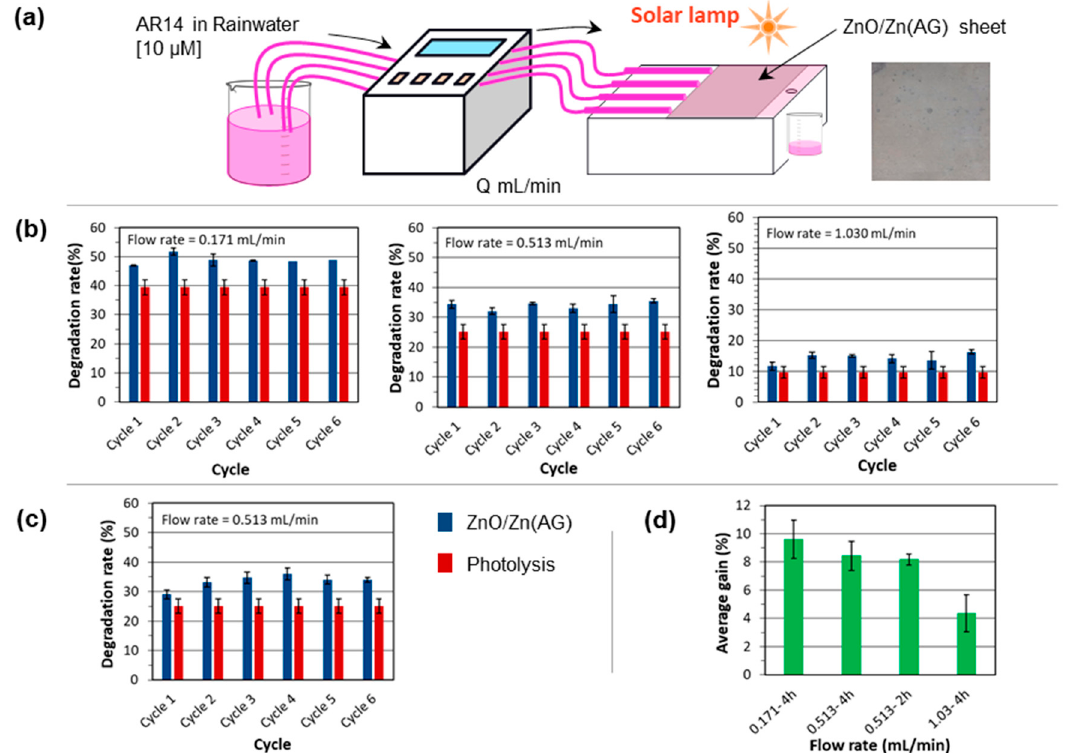
Figure 4. ( a ) Schematic of the experimental set-up of runoff water photodegradation with ZnO NSs on Zn roof sheets. Photodegradation rate of AR14 under artificial solar light with or without the presence of ZnO NSs: ( b ) at different flow rate: 0.171, 0.513, and 1.03 mL/min for 4 h-sample; ( c ) for 2 h-sample with a flow rate of 0.513 mL/min. ( d ) Comparison of the photocatalytic efficiencies for the different cases under studied.